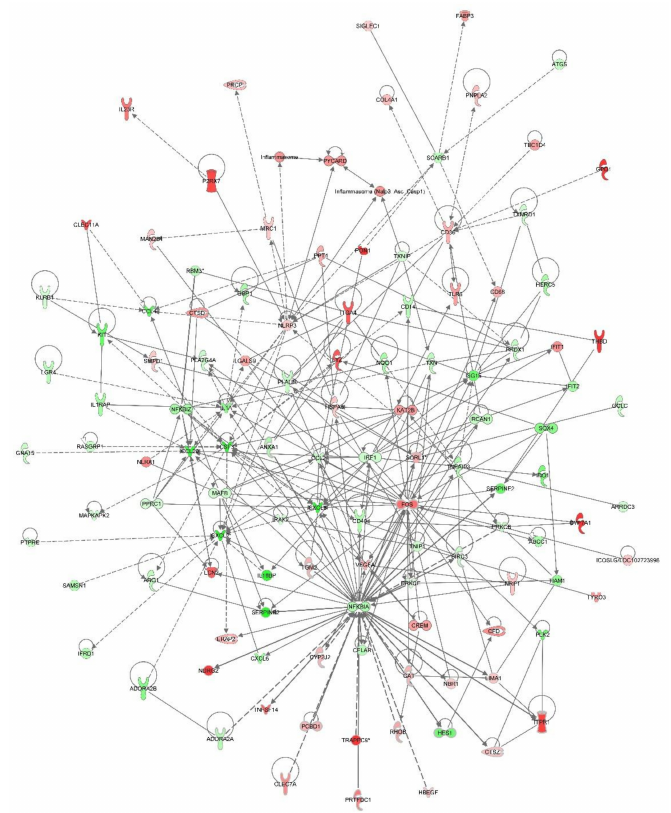
Figure 7. NLRP3 Inflammasome-associated genes di ff erentially expressed in PRRSV-infected PAMs. All genes shown were significantly ( p < 0.05) in PRRSV-infected PAMs in at least one time point (12, 24, and 48 hpi). Red molecules are significantly upregulated in PRRSV-infected macrophages relative to mock-infected cells and green molecules are